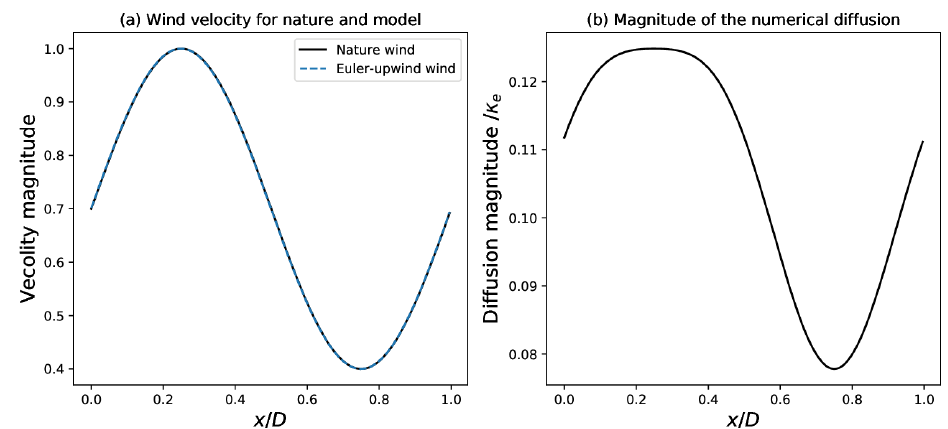
Figure 2. (a) Wind field specified for the nature dynamics and the one seen in the discretized model from Eq. (38b). Panel (b) represents the numerical diffusion coefficient due to the discretization equation (Eq. 38c), normalized by κ e = δx 2 /δt .